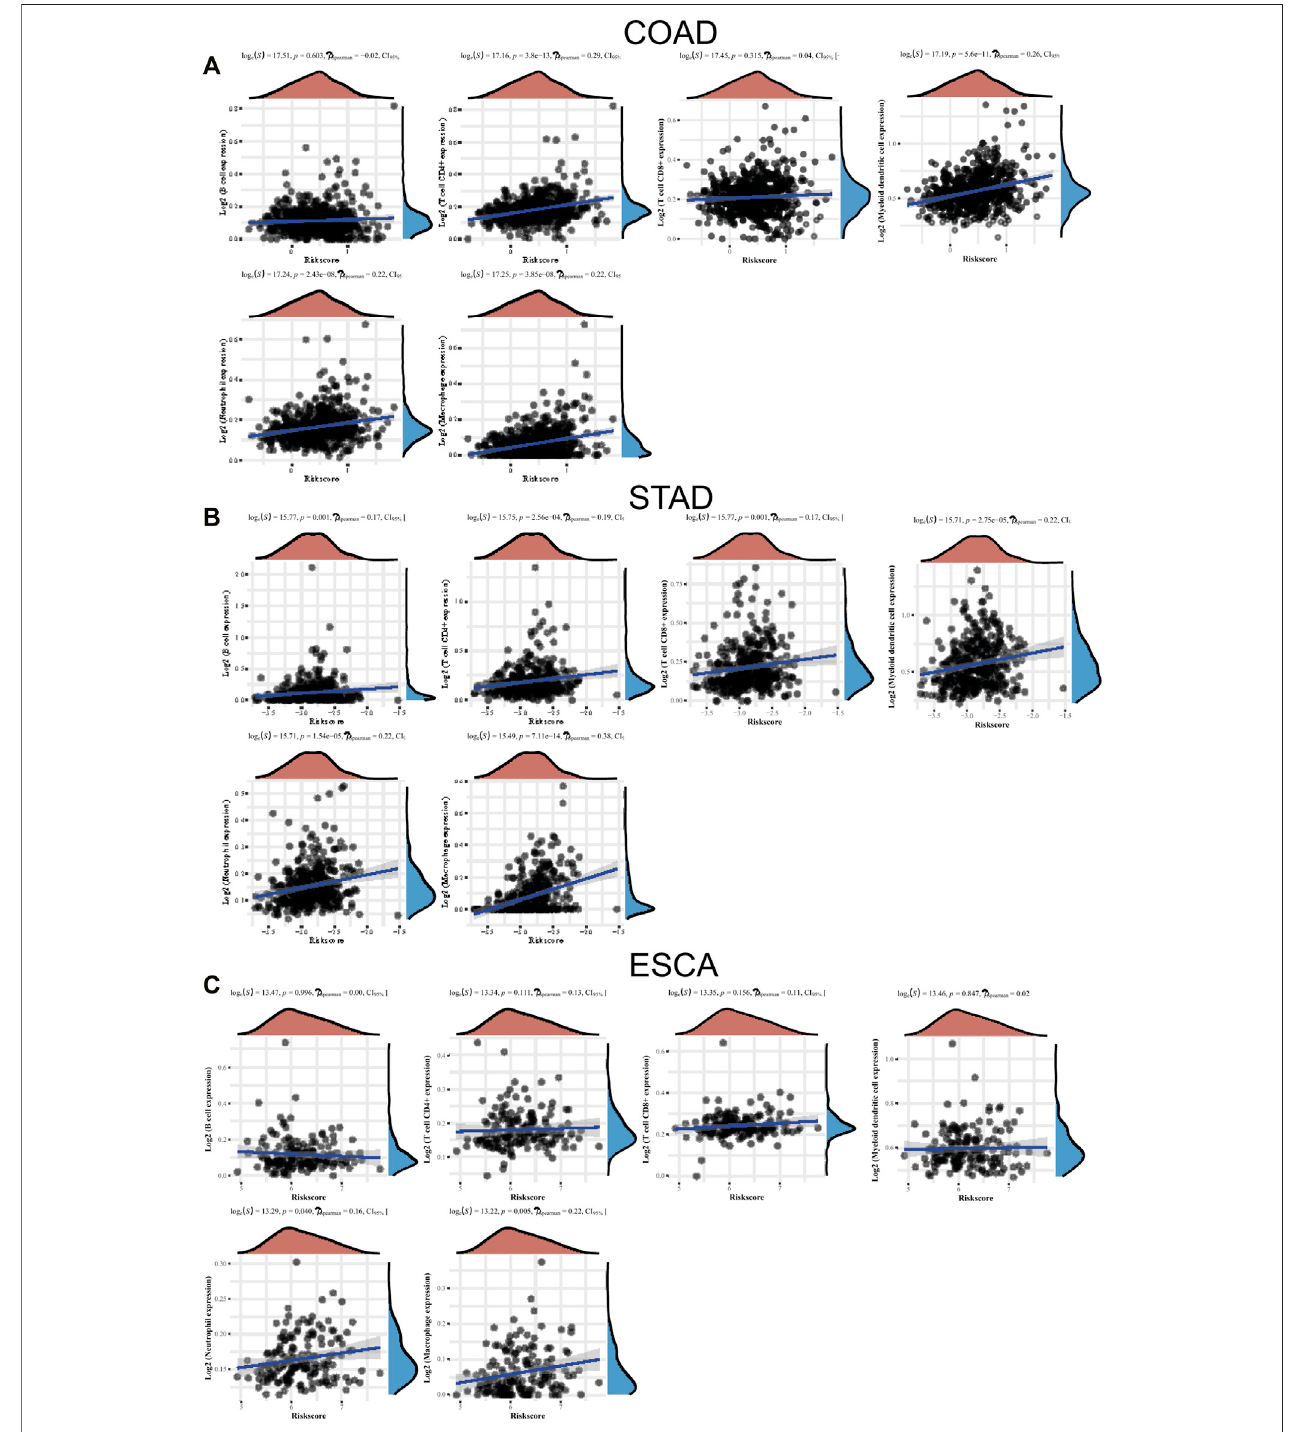
FIGURE 8 | The levels of LLPS regulators ’ signature associated with immune in fi ltration. (A – C) The LLPS regulators ’ signature score was related to the levels of B cells, CD4 + T-cell in fi ltration, CD8 + T-cell in fi ltration, neutrophil cell in fi ltration, macrophage in fi ltration, and myeloid dendriticcell in fi ltration in COAD (A) , STAD (B) , and ESCA (C) .